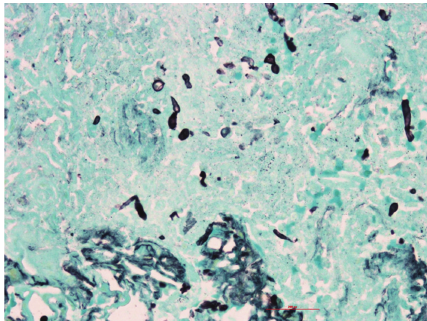
Figure 2: Pathological examination of explant revealed renal artery and intraparenchymal arterial branches positive for fungal organ- isms by GMS